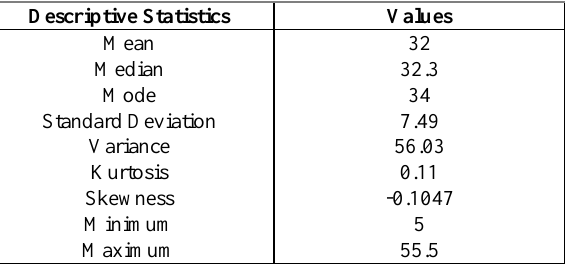
Table 1. Computed descriptive statistics for DBH (cm) values